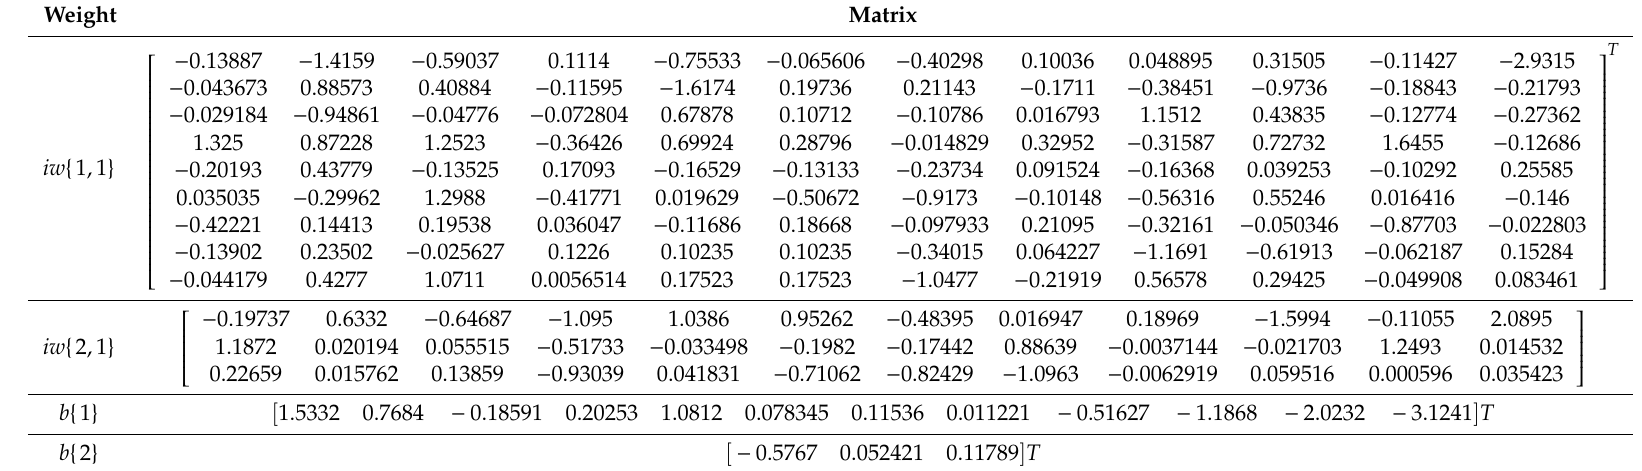
Table 9. The weights of the established